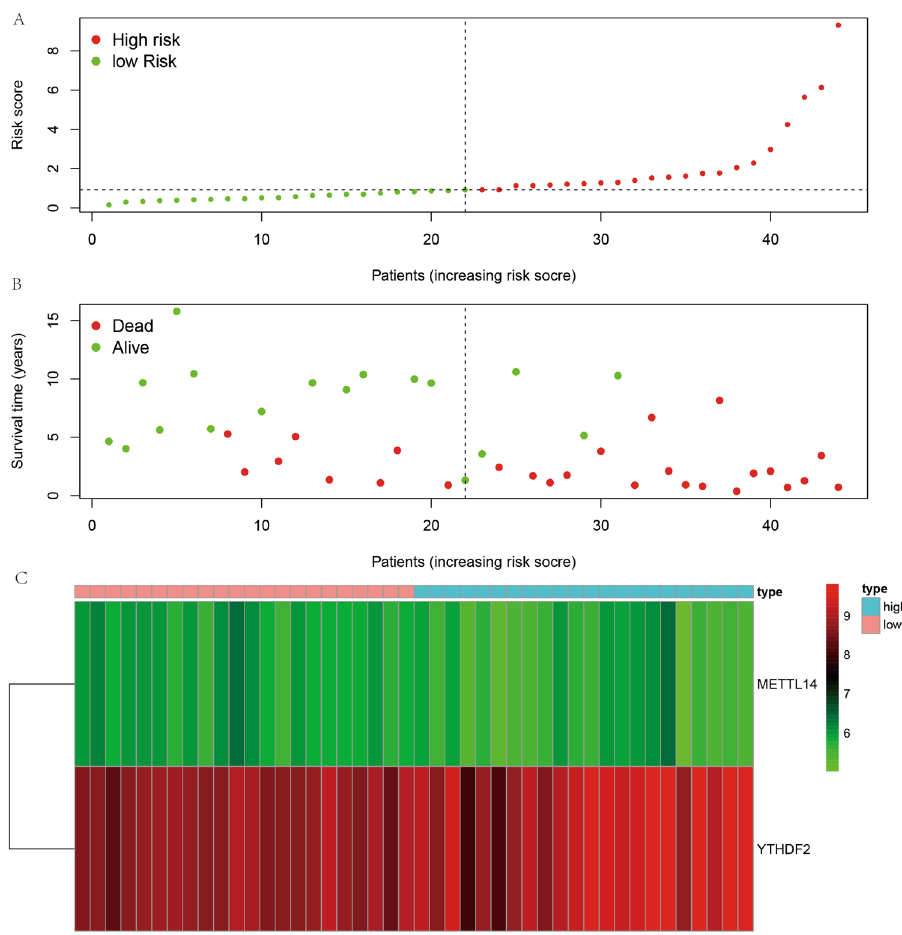
Figure 6. Risk graph for Ewing’s sarcoma cases. ( A ) represents the risk score chart based on the risk of the cases in order from ground to high. ( B ) represents the graph of survival and death of the cases. ( C ) represents the expression of METTL14 and YTHDF2 in high and low risk